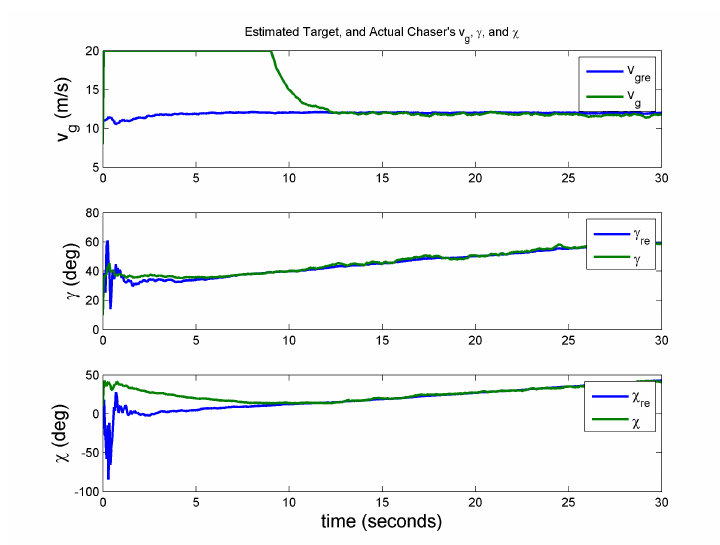
Figure 25. Estimated target and chaser ( v g , γ , χ ), (Case 3).